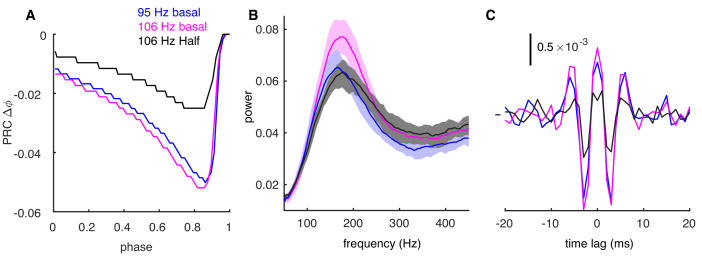
Decreased PRC at high firing rates can weaken oscillations.(A) PRCs for negative synaptic stimulus when PCs fire at 95 Hz (blue) and 106 Hz (purple) driven by OU process with basal values of synaptic conductance. Reduced PRC at 106 Hz was achieved by 50% of basal synaptic conductance (black). (B) The power spectrum of spike trains with the cellular rate of 95 Hz (blue, basal conductance), 106 Hz (purple, basal conductance) and 113 Hz (black, 50% of basal conductance, firing rate increased to 113 Hz due to the reduced inhibition, with other conditions the same as 106 Hz with basal conductance). In all cases, the CV of ISI is 0.45. The power spectrum at high firing rates gets flatter with lower amplitude when the PRC amplitude is reduced (black trace). (C) The CCGs of spike trains with the same condition as in B. Central and side peaks reduce at high firing rates when the phase response is smaller.